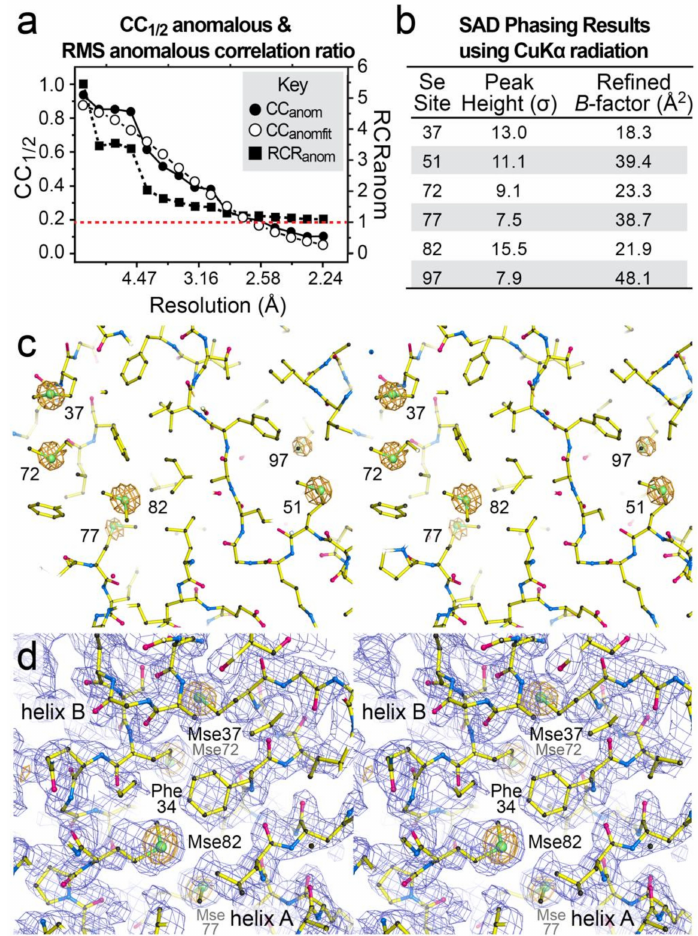
Figure 7. Selenomethionine anomalous signal, substructure determination and representative noise-filtered SAD-phasing electron-density map of dmU1A(F37M/F77M). ( a ) ( Left ordinate ) Plot of the anomalous difference correlation coefficients CC anom and CC anomfit as a function of resolution. ( Right ordinate ) Plot of RMS correlation ratio for anomalous diffraction (RCR anom ) as a function of res- olution. A dashed red line indicates a value of 1.0 for the RCR anom signal. Parameters are defined as described in Aimless [86]. ( b ) Results of Se-substructure identification using a hybrid search [76] and values of the refined B -factors from the corresponding model in Figure 6. The heights of the six selenium anomalous difference Fourier peaks were derived from Phaser EP [72]. ( c ) Stereo view of the anomalous difference Fourier peaks from panel b , shown in the correct hand and contoured at 5 σ ; the final refined model of dmU1A(F37M/F77M) from Figure 6 is shown. ( d ) The noise- filtered SAD phasing map contoured at 1.0 σ (slate blue) shows recognizable secondary structure features. The refined model from Figure 6 is shown and fits well to the experimental electron density. The anomalous difference Fourier map contoured at 4 σ is shown to emphasize the locations of the site I Se